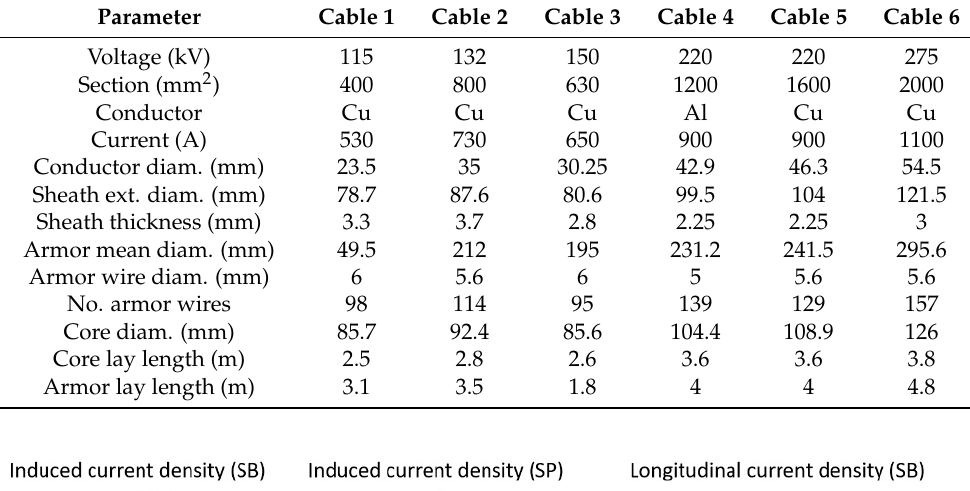
Table 3. Main parameters for test cables.